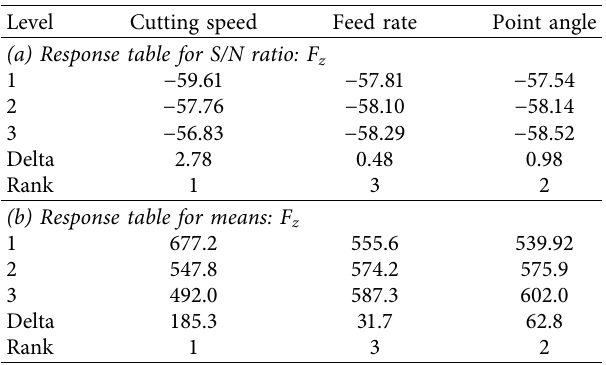
Table 3: Response table F